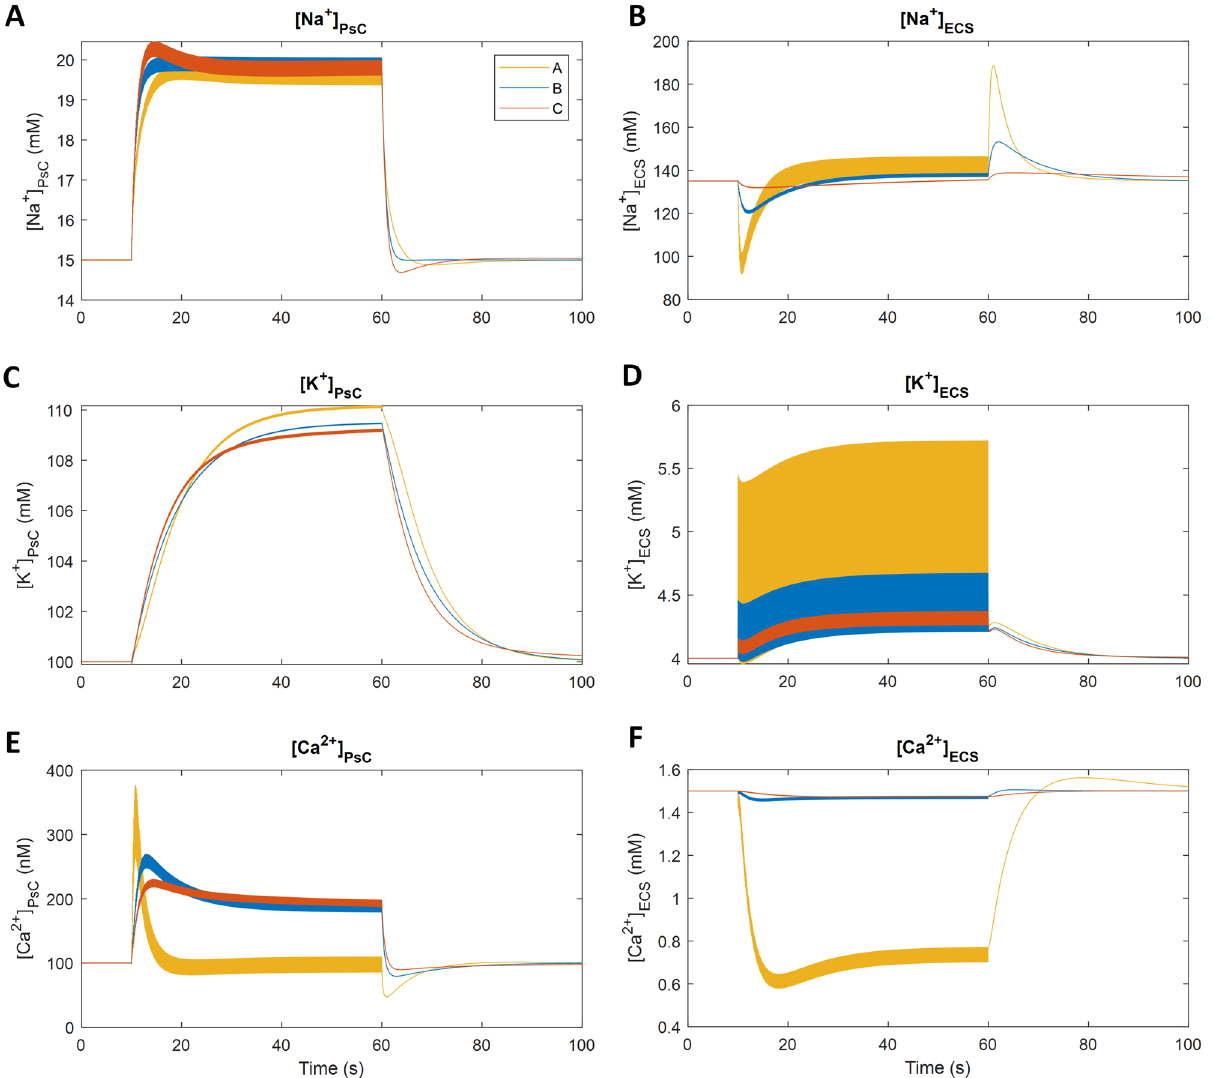
Figure 6. Comparison of ionic concentrations with variable degrees of PsC coverage of the neuronal synapse. The concentrations of Na + , K + and Ca 2+ in the PsC are shown in the left-hand column ( A , C , E ) and the ionic concentrations in the ECS are shown in the right-hand column ( B , D , F ). ( A ) (yellow line) is when the ECS volume is equal to the cleft volume, representing a synapse in direct contact with a PsC. ( B ) (blue line) is the ECS volume used in all previous model simulations, which is seven times the cleft volume, representing a semi- enwrapped synapse. ( C ) (orange line) is when the ECS volume is forty-nine times that of the cleft, representing a synapse with a relatively distant